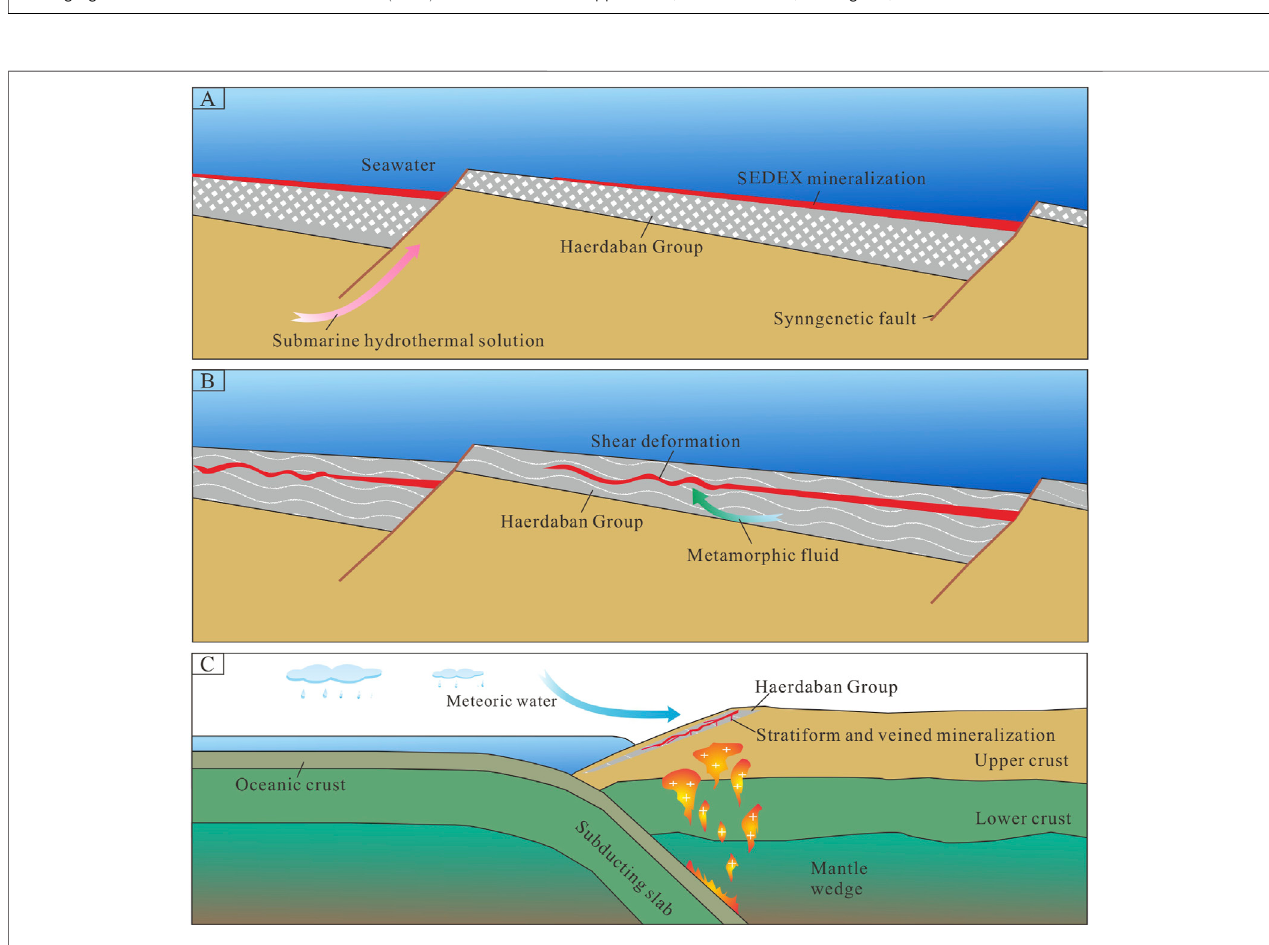
FIGURE8| Leadisotopecompositionsforsul fi desoftheHaerdaban Pb-Zndeposit (A) 207 Pb/ 204 Pbvs 206 Pb/ 204 Pbplot (B) 208 Pb/ 204 Pbvs 206 Pb/ 204 Pbplot.The average growth curve is from Zartman and Doe (1981). Abbreviations: UC-upper crust; LC-lower crust; O-orogenic; M-mantle.